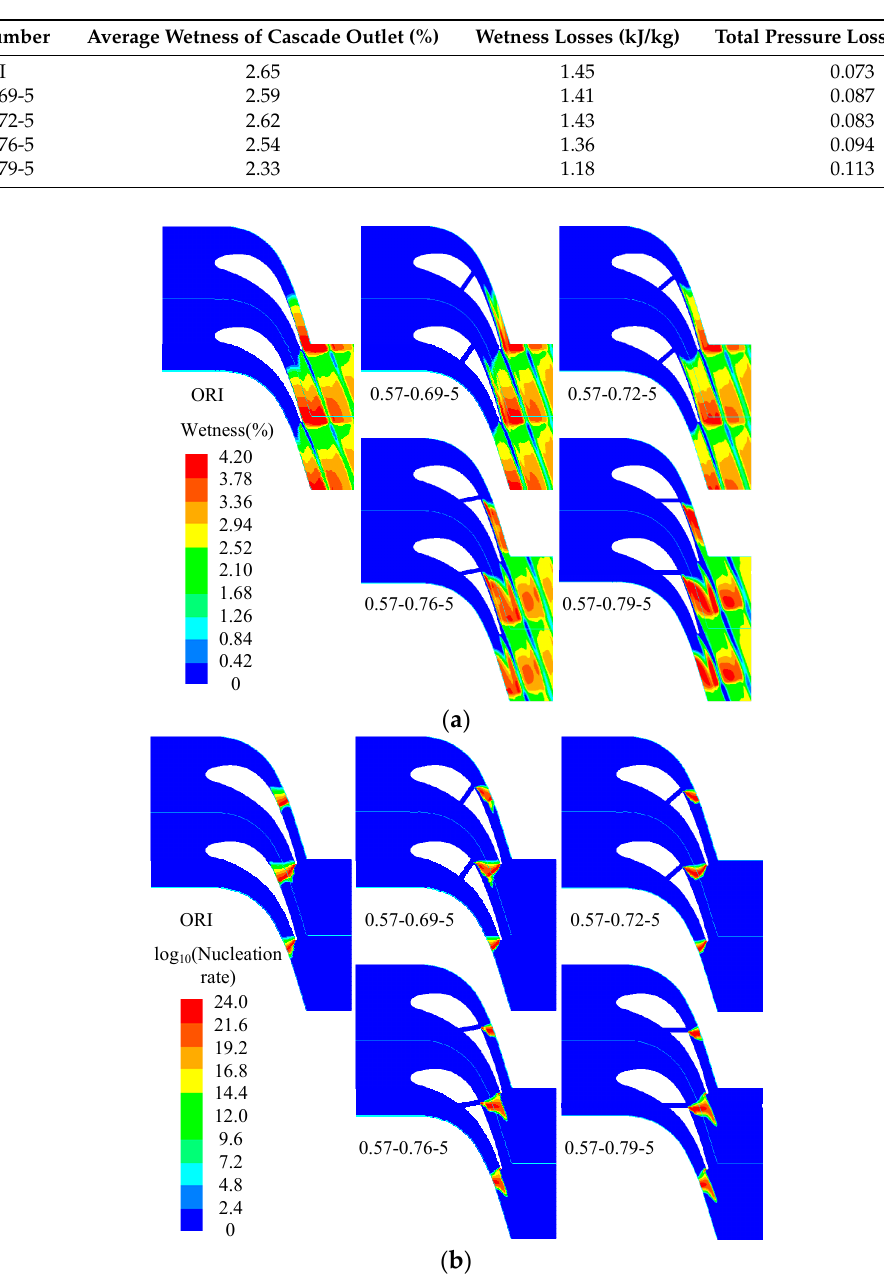
Figure 5. Distribution of ( a ) wetness distribution and ( b ) nucleation rate (part 1).